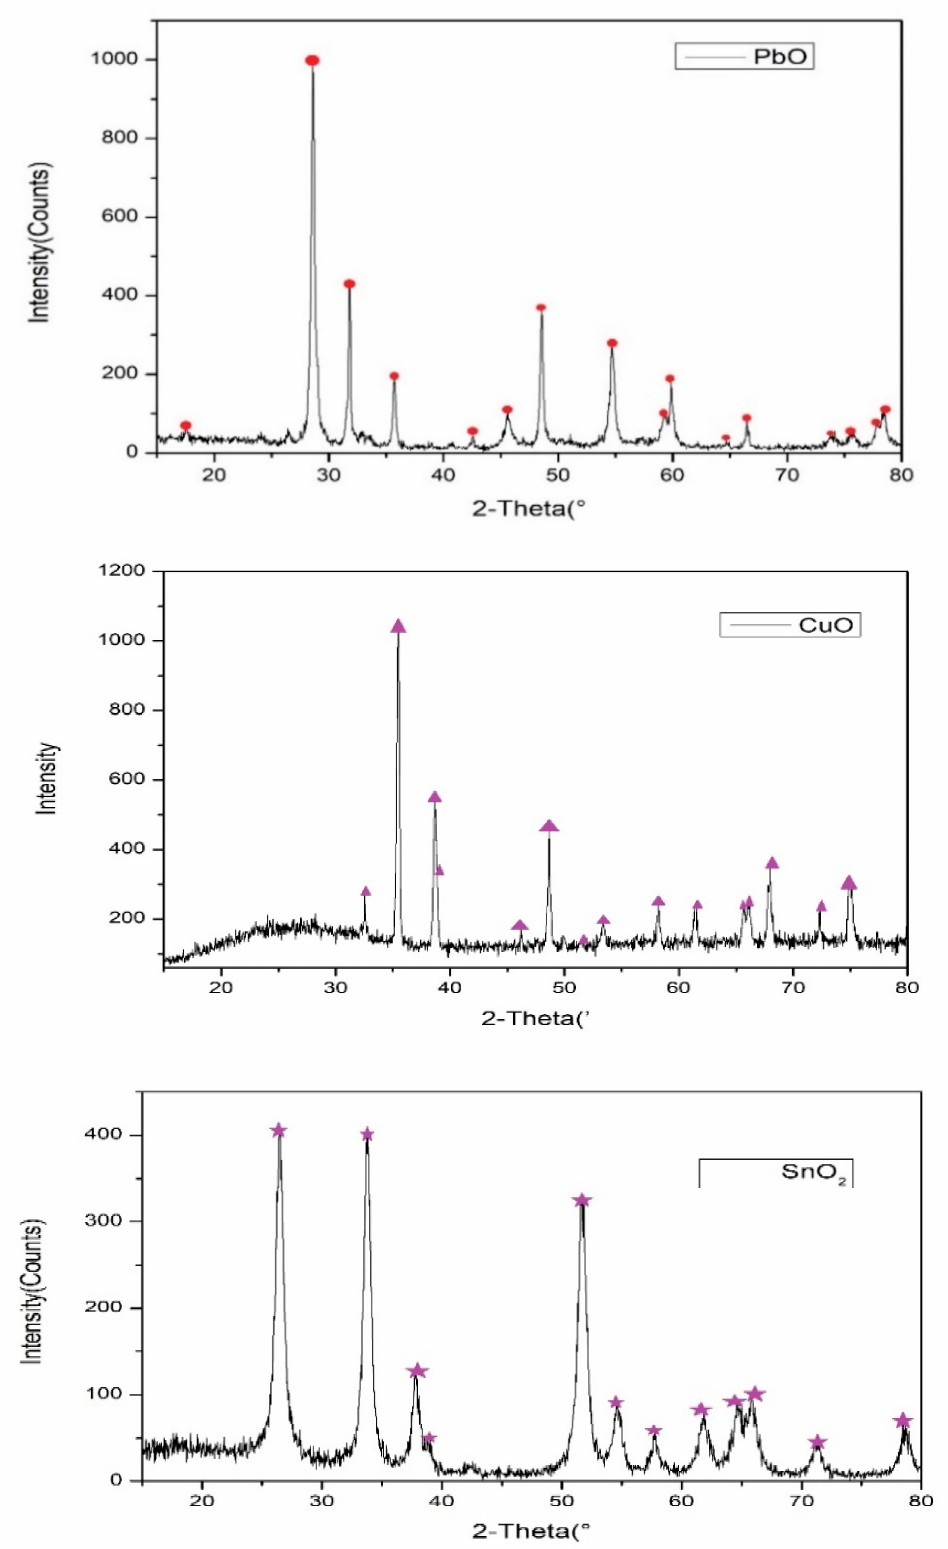
Figure 13. XRD diagrams of CuO, SnO 2 , and